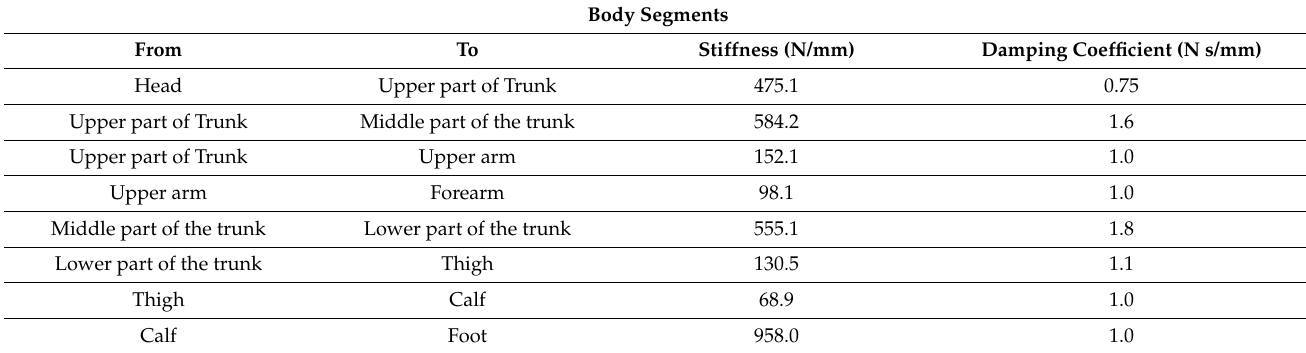
Table A2. Stiffness and damping coefficients for spring [47] and damper [48].